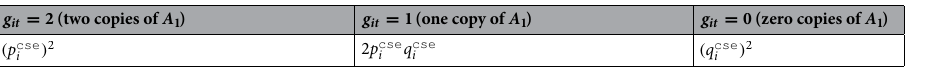
cse i denotes the allele frequency of